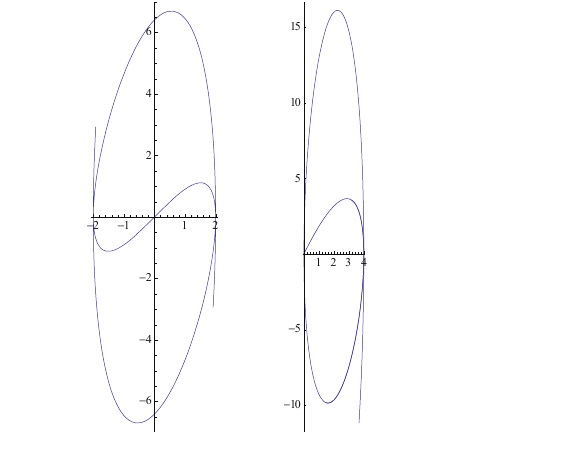
Fig. 1. A dual circle is a product curve of above two curves in D .